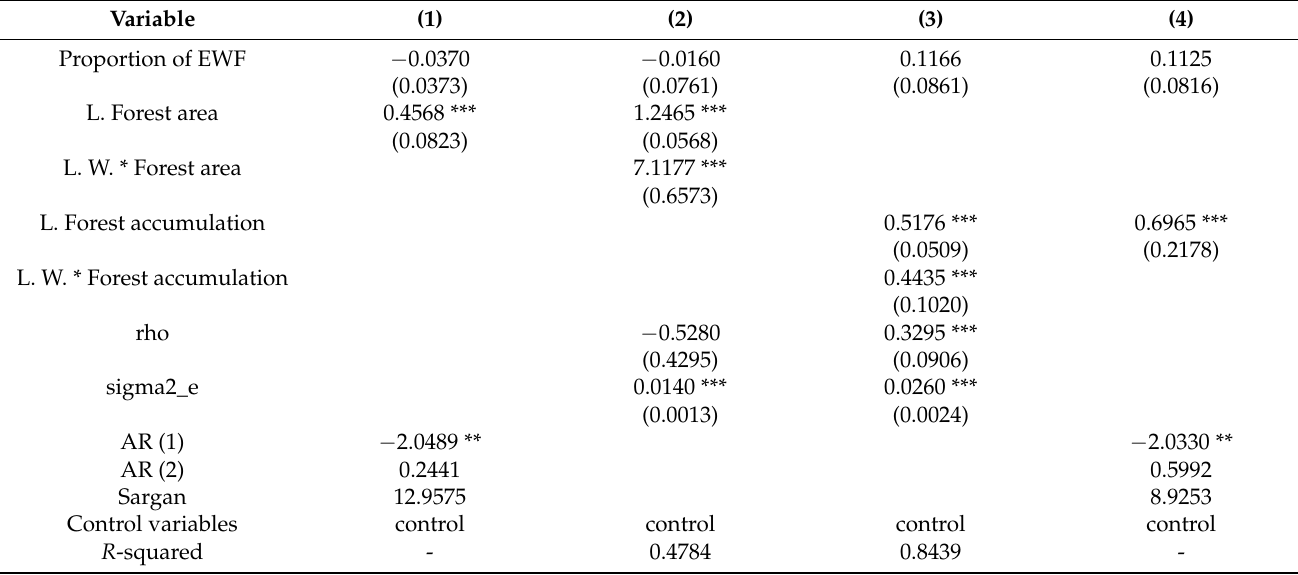
Table 4. Endogeneity and empirical robustness